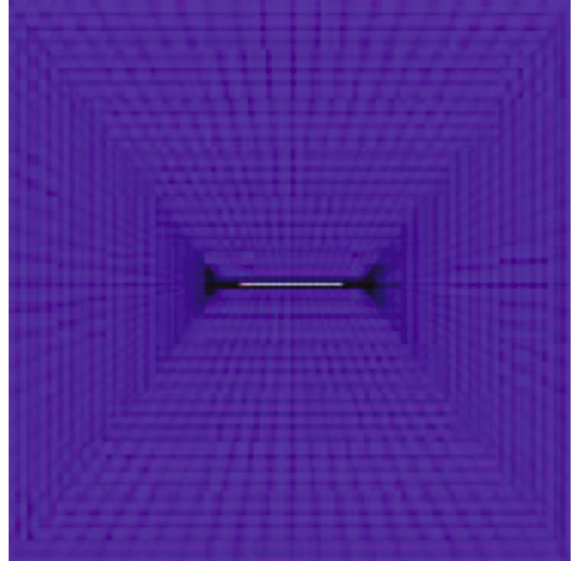
Figure 4: Finite element